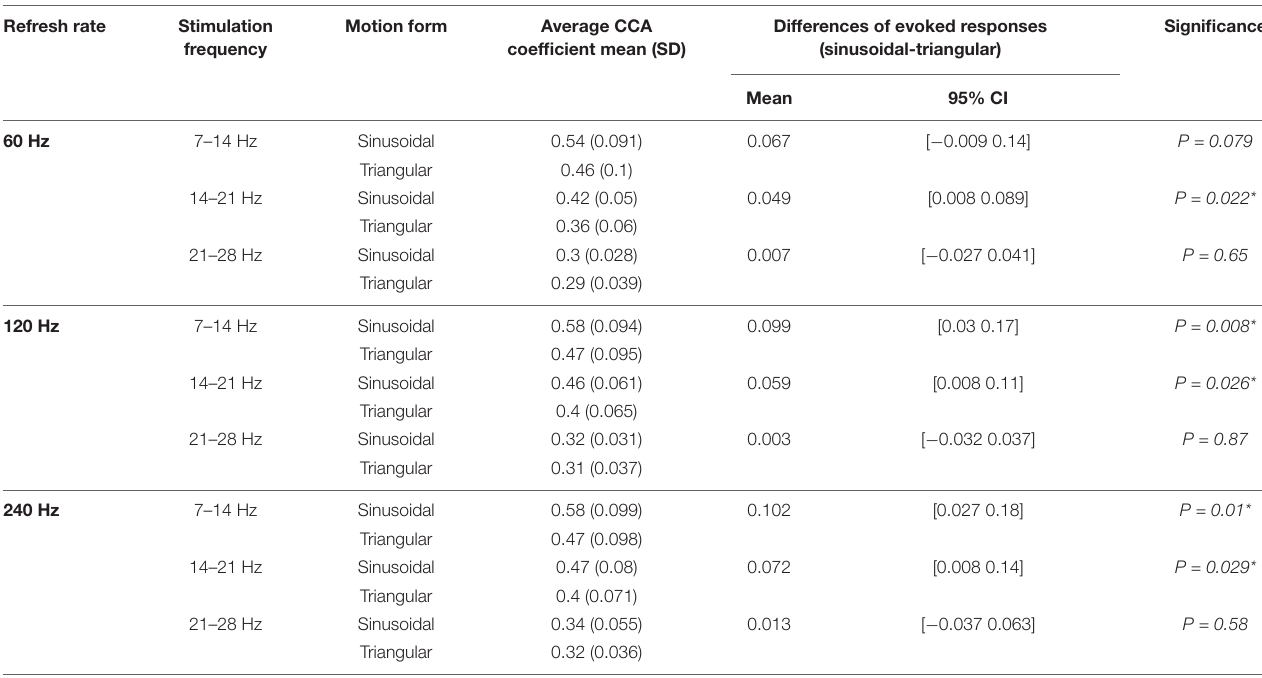
FIGURE 7 | The post hoc comparison results and relative proportion comparison of triangular motion stimulation. (A) The histogram of triangular motion stimulation-evoked responses, including the mean and standard deviation. The asterisks indicate that the difference is statistically significant at the level of α = 0.05. (B) The relative proportion of triangular stimulation-evoked responses under different refresh rates in each stimulation frequency range. The vertical axis indicates the relative proportion, the horizontal axis indicates the refresh rate, and the black dotted thin line is used to separate different stimulation frequencies. TABLE 3 | The simple effect analysis results of motion